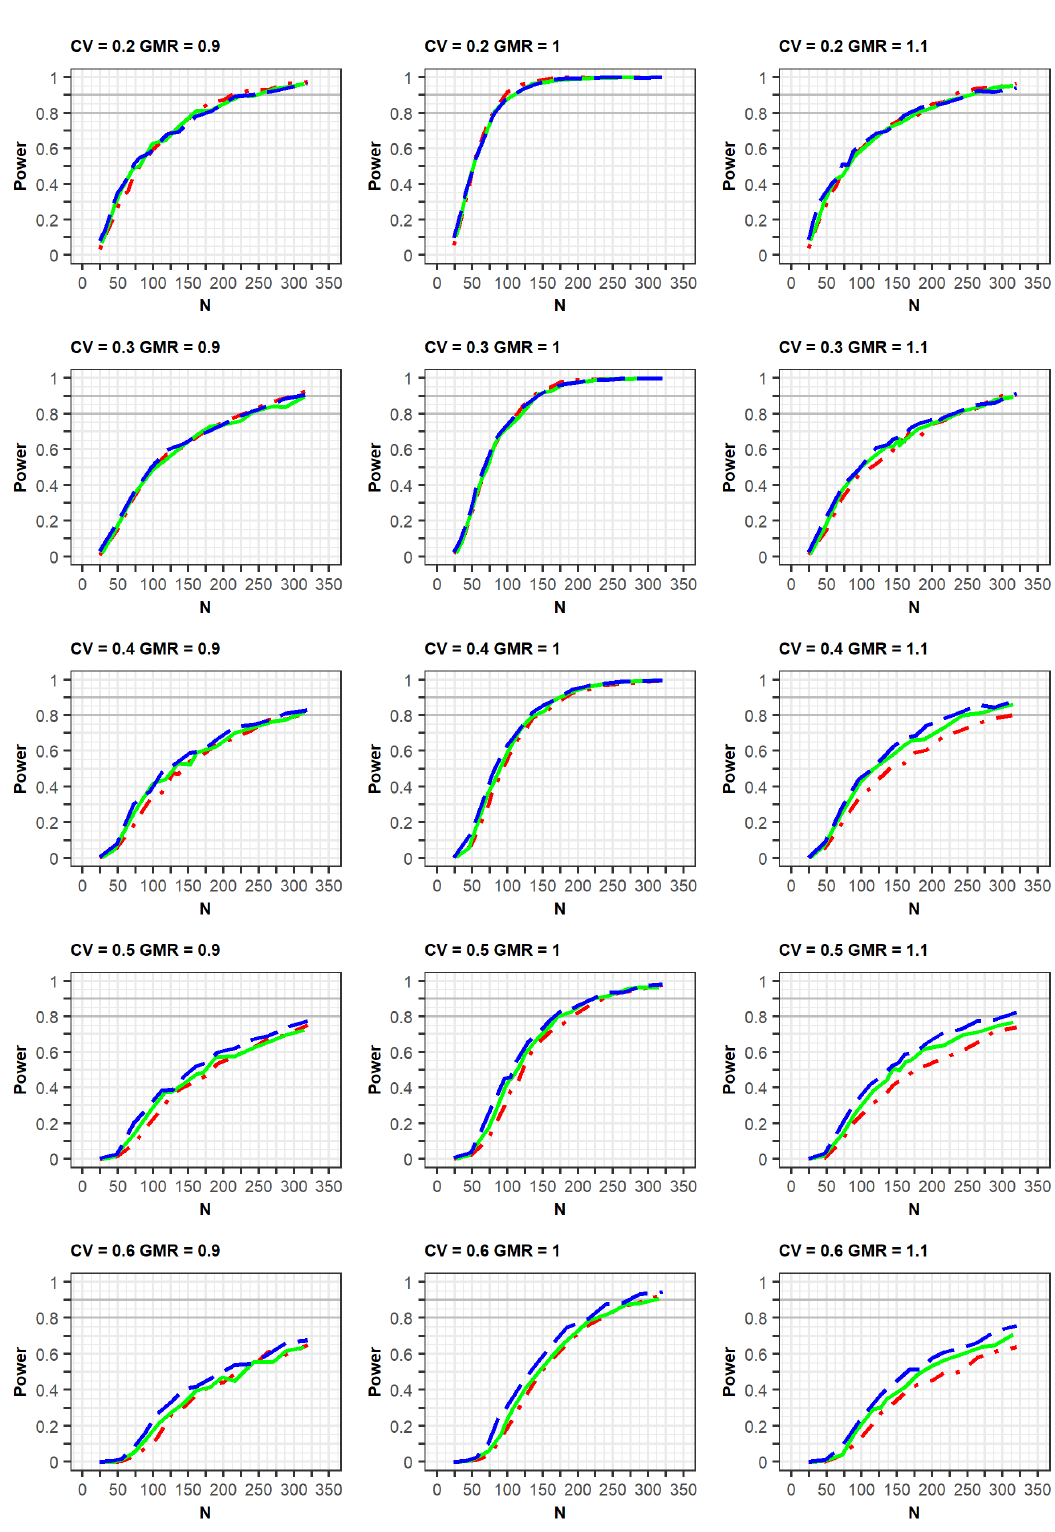
Figure 2. Comparison of power calculated as per the EMA guidelines among clinical trial designs: 2 × 2 design (red dot–dashed line), 3 × 3 design (green solid line), and 2 × 4 design (blue long-dashed line). The x-axis and y-axis represent the total number of trials (N) and statistical power, respectively.